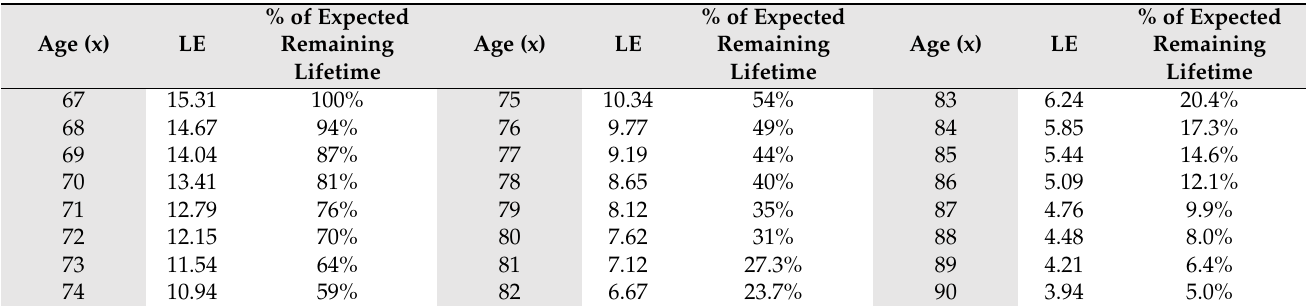
Table 3. Life expectancy (based on the 2017 Hungarian unisex mortality table) and what percentage of the life expectancy (LE) at age 67 exceeds the given age. Age